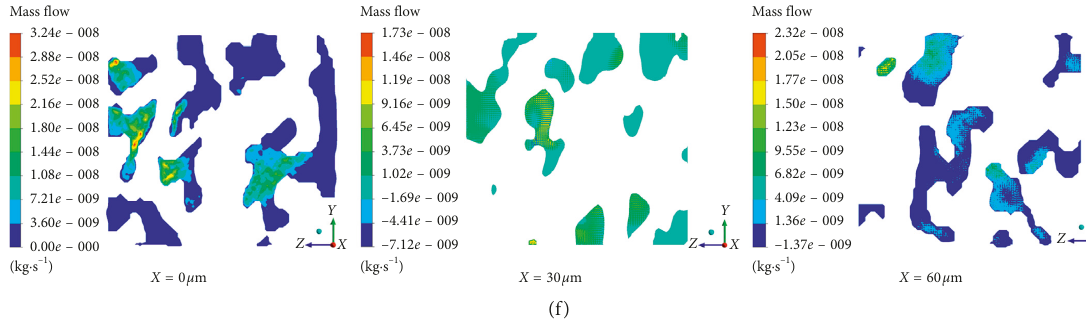
Figure 15: Distributions of mass flows in model P 1 on different sections under different water injection pressures. (a) 0.3MPa. (b) 1.7MPa. (c) 4.3MPa. (d) 8.1MPa. (e) 13.1MPa. (f)